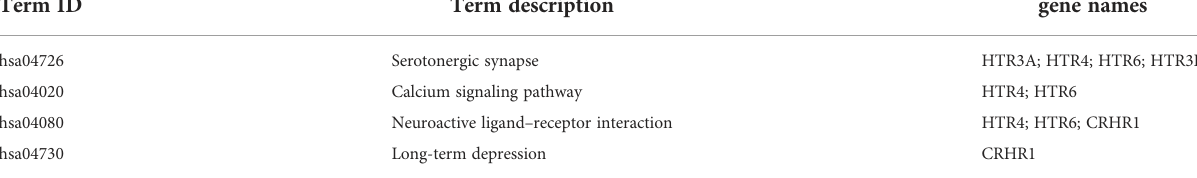
TABLE 3 Targets to IBS predicted by the TTD and OMIM